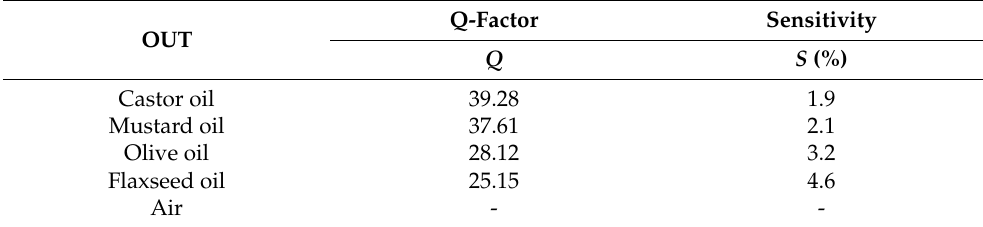
Table 3. Sensitivity and quality